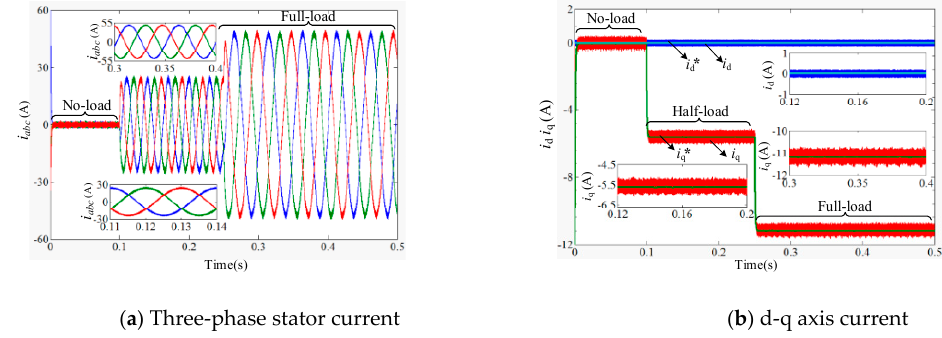
Figure 13. Current waveforms of three-phase PMSG unit 1 with PI-NRC.